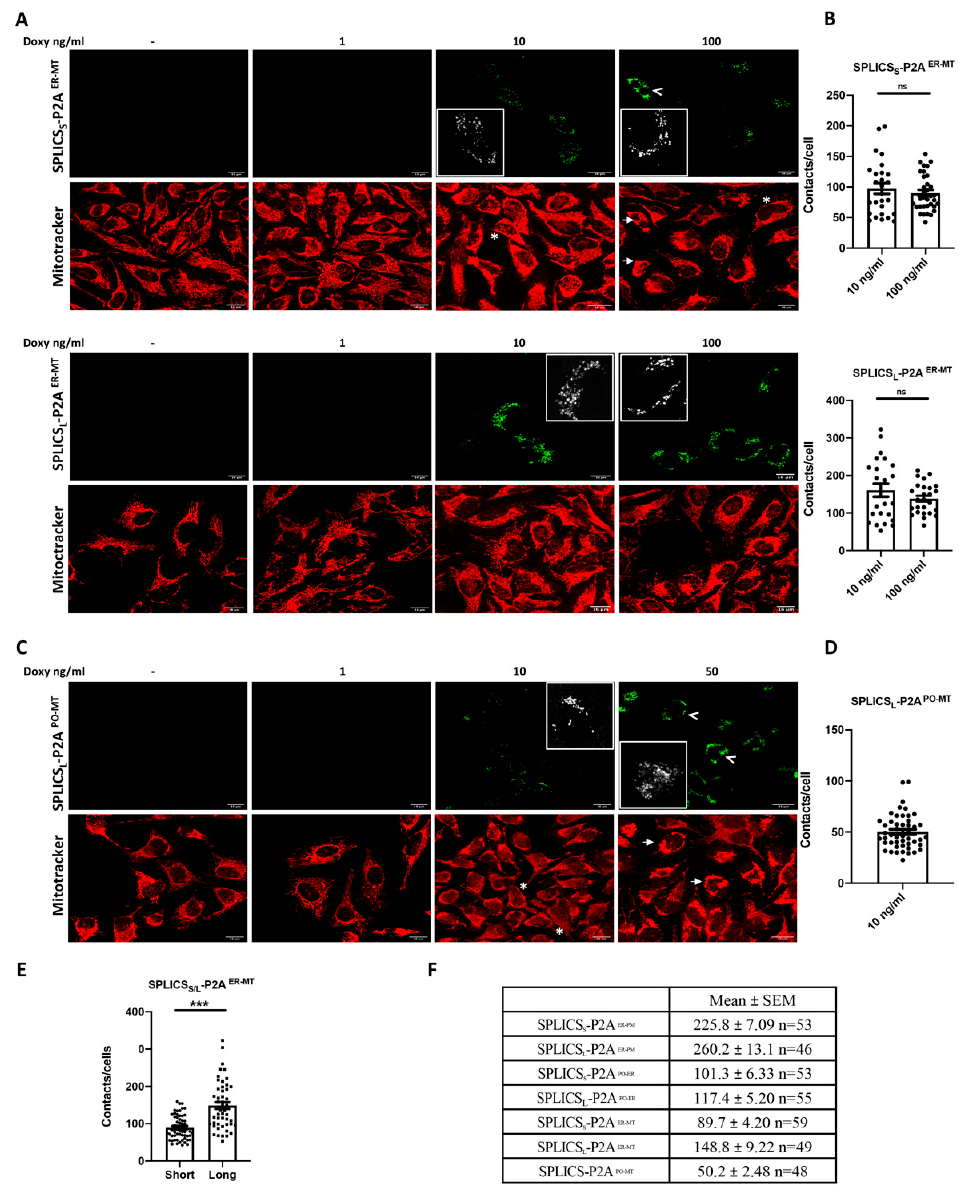
Figure 4. Characterization of HeLa polyclonal stable cell lines expressing SPLICS S/LER-MT and SPLICS LPO-MT . ( A , C ) Representative Z-projection images of CTRL HeLa expressing SPLICS S/L ER-MT and SPLICS LPO-MT (upon excitation at 488 nm) treated with increasing concentrations of doxycycline for 24 h. MitoTracker™ Red CMXRos (578 nm) was used to detect mitochondria morphology. SPLICS altered signal is indicated by the white arrowheads. Scale bar 16 µ m. ( B , D ) Quantification of the indicated SPLICS contact sites/cell was performed from the 3D rendering of a complete Z-stack at 10 and 100 ng/mL of doxycycline for ER-MT S/L and at 10 ng/mL for PO-MT. Data are shown as mean ± SEM dots ( n = 3 independent experiments) and analyzed by t -test. Representative merge panels for SPLICS S/L ER-MT and SPLICS L PO-MT at 488/578 nm of the two higher doxycycline concentrations. ns: not significant. ( E ) Quantification of SPLICS S/L ER–MT (both at 10 and 100 ng/mL of doxycycline) contacts by 3D rendering of complete Z-stacks, mean ± SEM of three independent experiments and analyzed by t -test (*** p < 0.001). ( F ) Mean ± SEM values of the number of ER-PM, PO-ER, ER–MT contacts, short and long, and the number of PO-MT contacts. Inset: zoomed